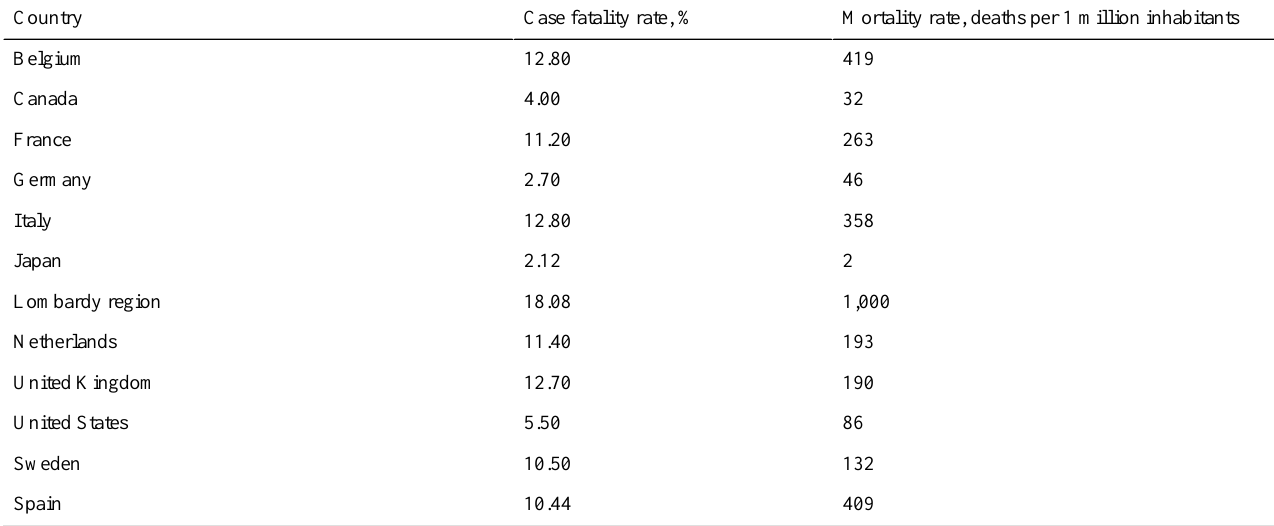
Table 1. Comparison of the case fatality rate and mortality rate in Italy and the Lombardy region with those of the other G10 countries.